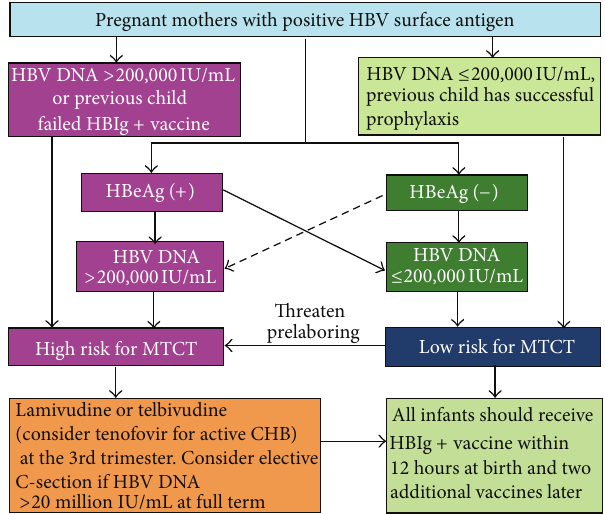
Figure 1: Algorithm for risk assessment and prevention of MTCT of HBV. Adopted from Clinical Gastroenterology and Hepatology 2012; 10;